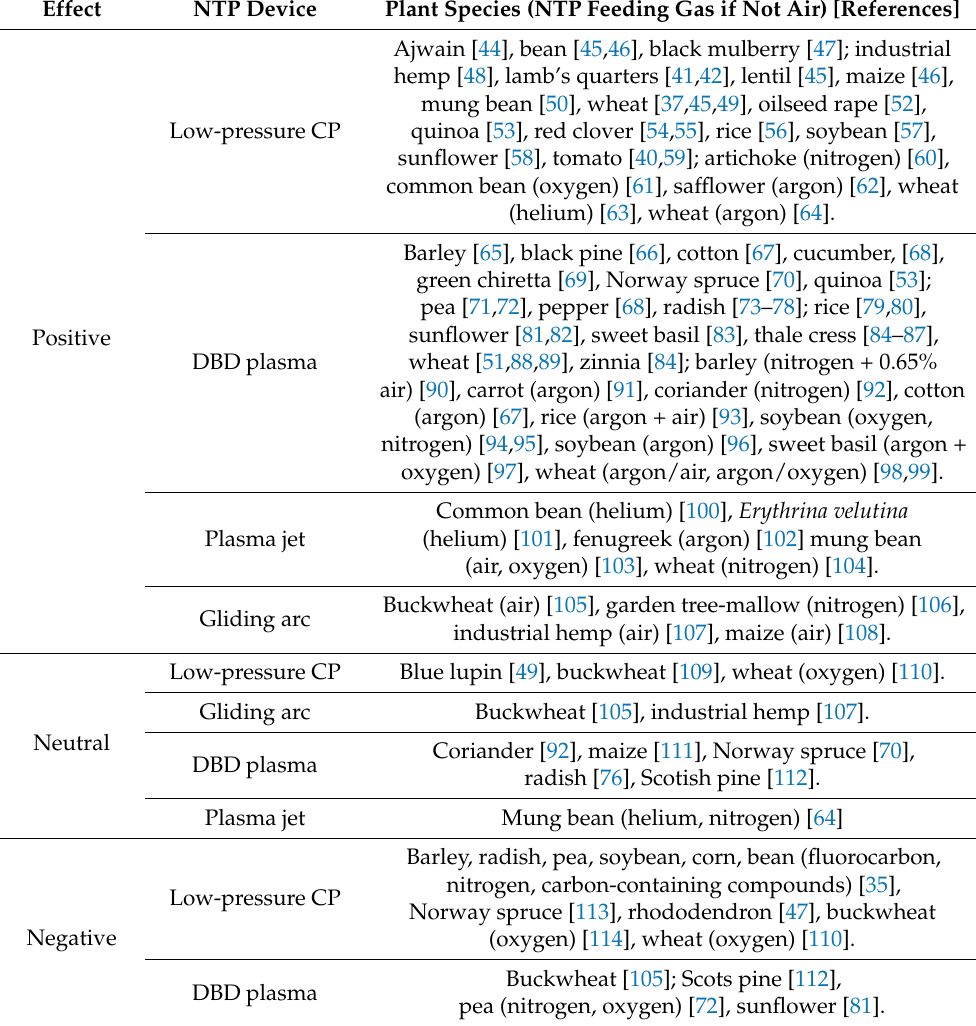
Table 1. Effects of different plasma treatment equipment on plant germination in